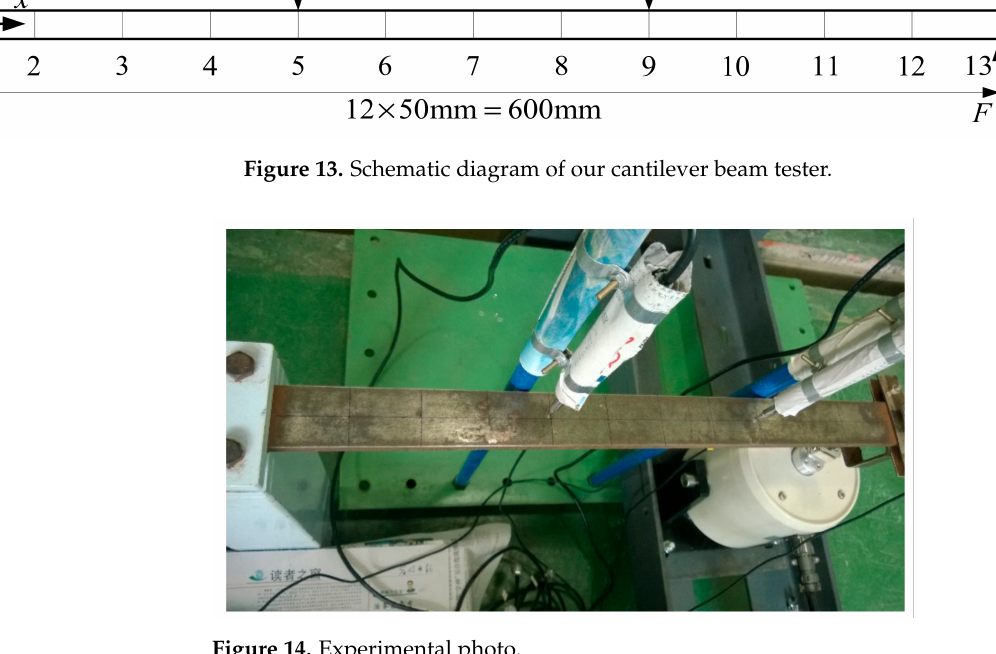
Figure 14. Experimental